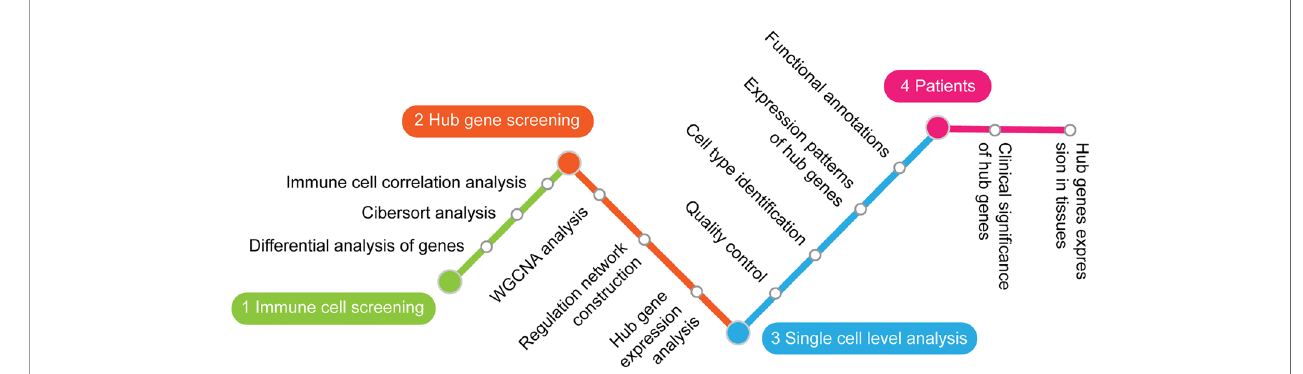
FIGURE 1 | A fl owchart showing the steps in this